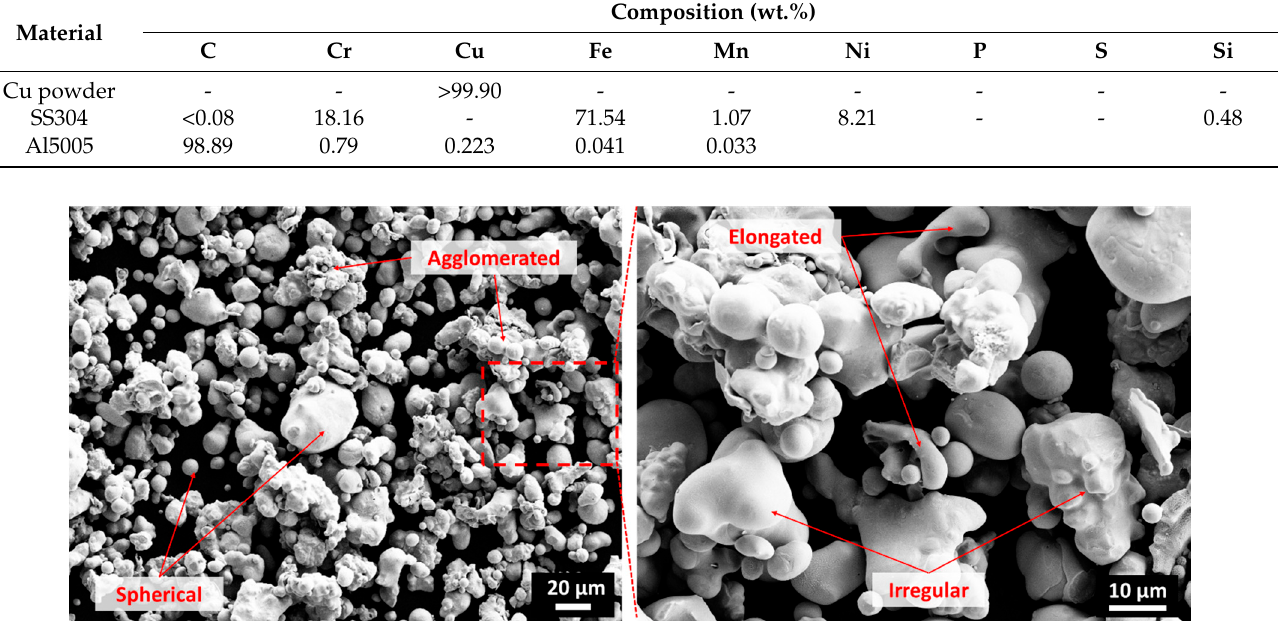
Figure 1. Scanning electron microscope (SEM) images of copper powder consisting of a mixture of spherical, agglomerated, elongated, and irregular ‐ shaped particles.